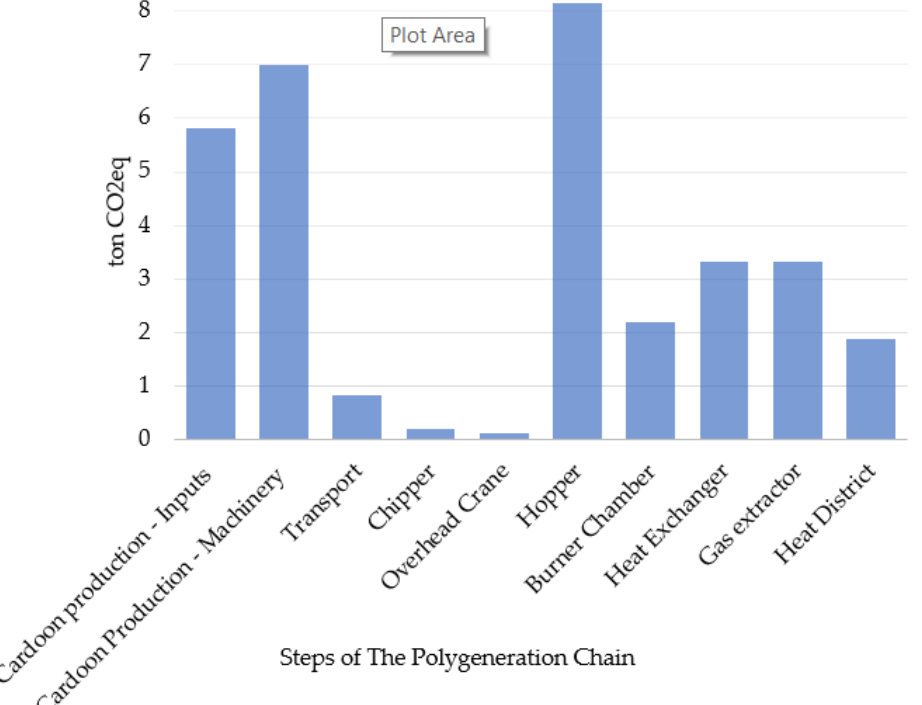
Figure 5. Global warming potential — characterisation — polygeneration chain.